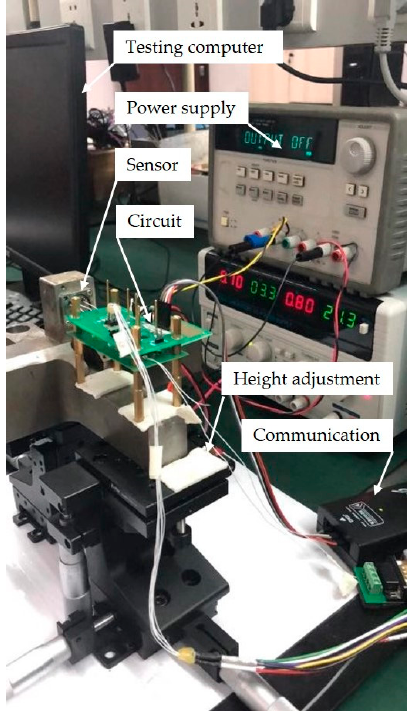
Figure 7. Experimental setup of the dead time test system.